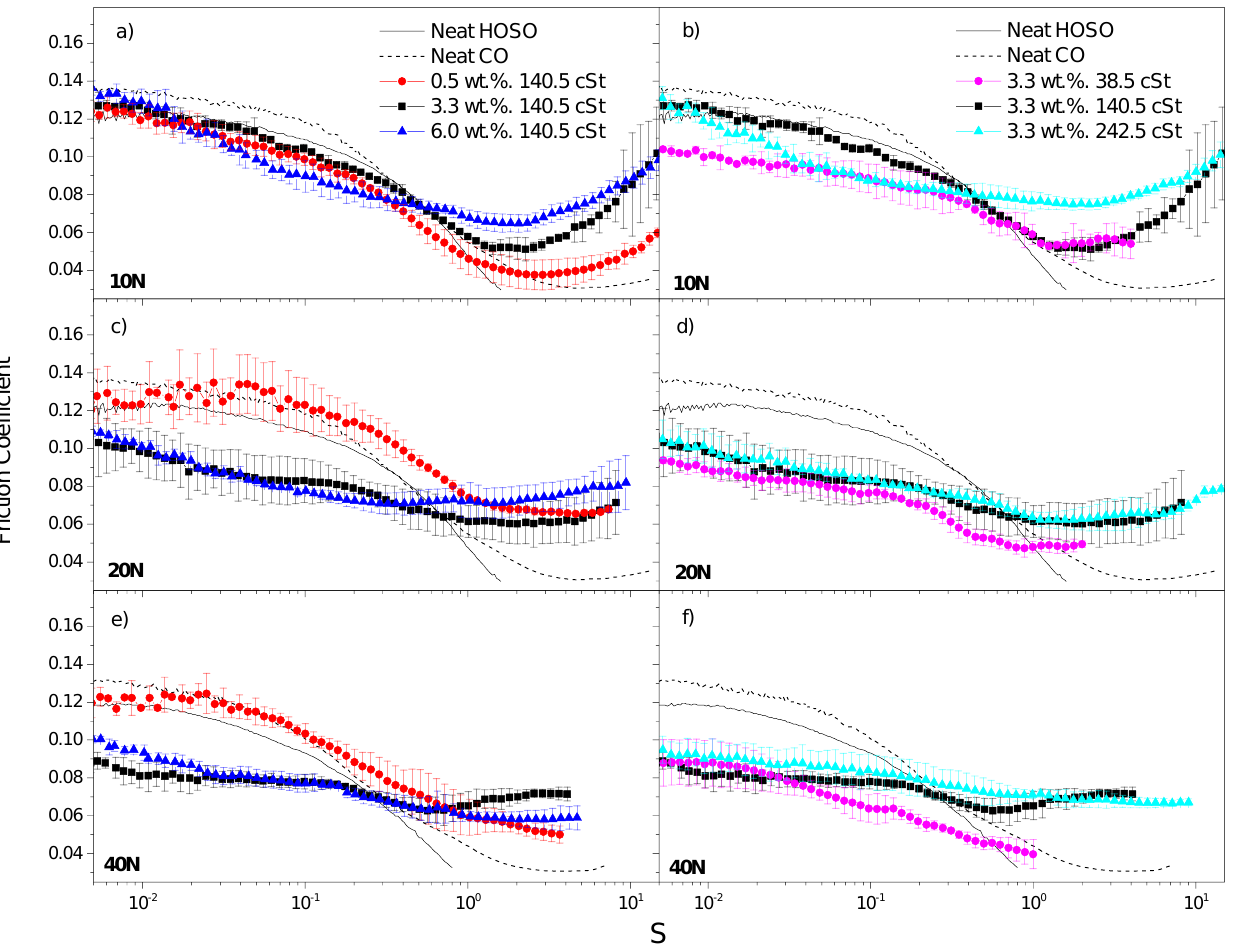
Figure 4. Stribeck curves for CNC-based dispersions, at 25 ◦ C, as a function of nanocellulose concentration ( a , c , e ) and base oil viscosity ( b , d , f ) at 10, 20 and 40 N (first, second and third rows, respectively). Neat base oils are included for the sake of comparison.